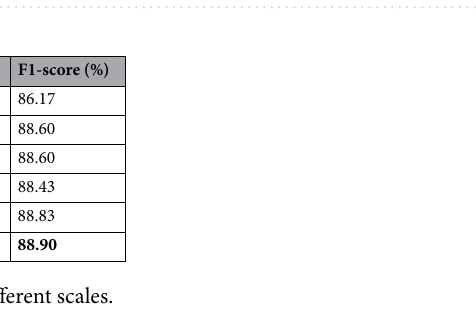
Figure 8. Comparison of MSCNN, EMSCNN and other models in the validation set.